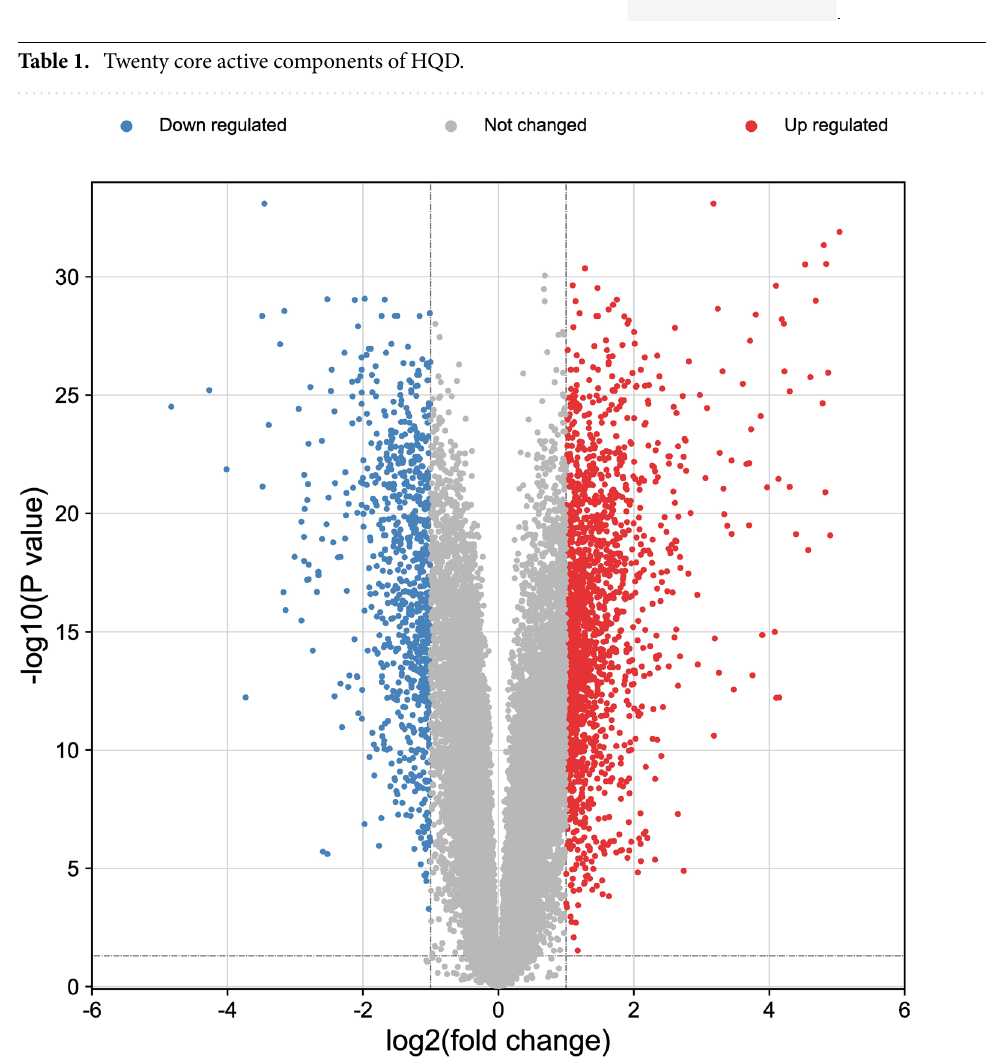
Figure 3. Volcano plot of DEGs. 1024 red dots are upregulated genes. 518 blue dots are downregulated genes. DEGs are defined with the cut-off criteria of |Log2FC|> 1 and adjusted P -value < 0.05.